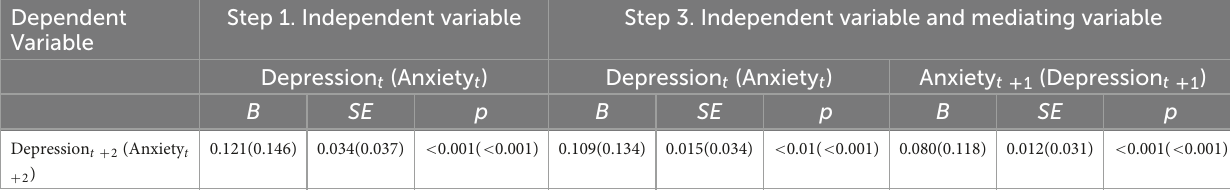
TABLE 6 Step 1 and Step 3 in mediating analysis of Depression t , Anxiety t + 1 , and Depression t + 2 are outside the parentheses; mediating analysis of Anxiety t , Depression t + 1 , and Anxiety t + 2 are inside the parentheses. Dependent Variable